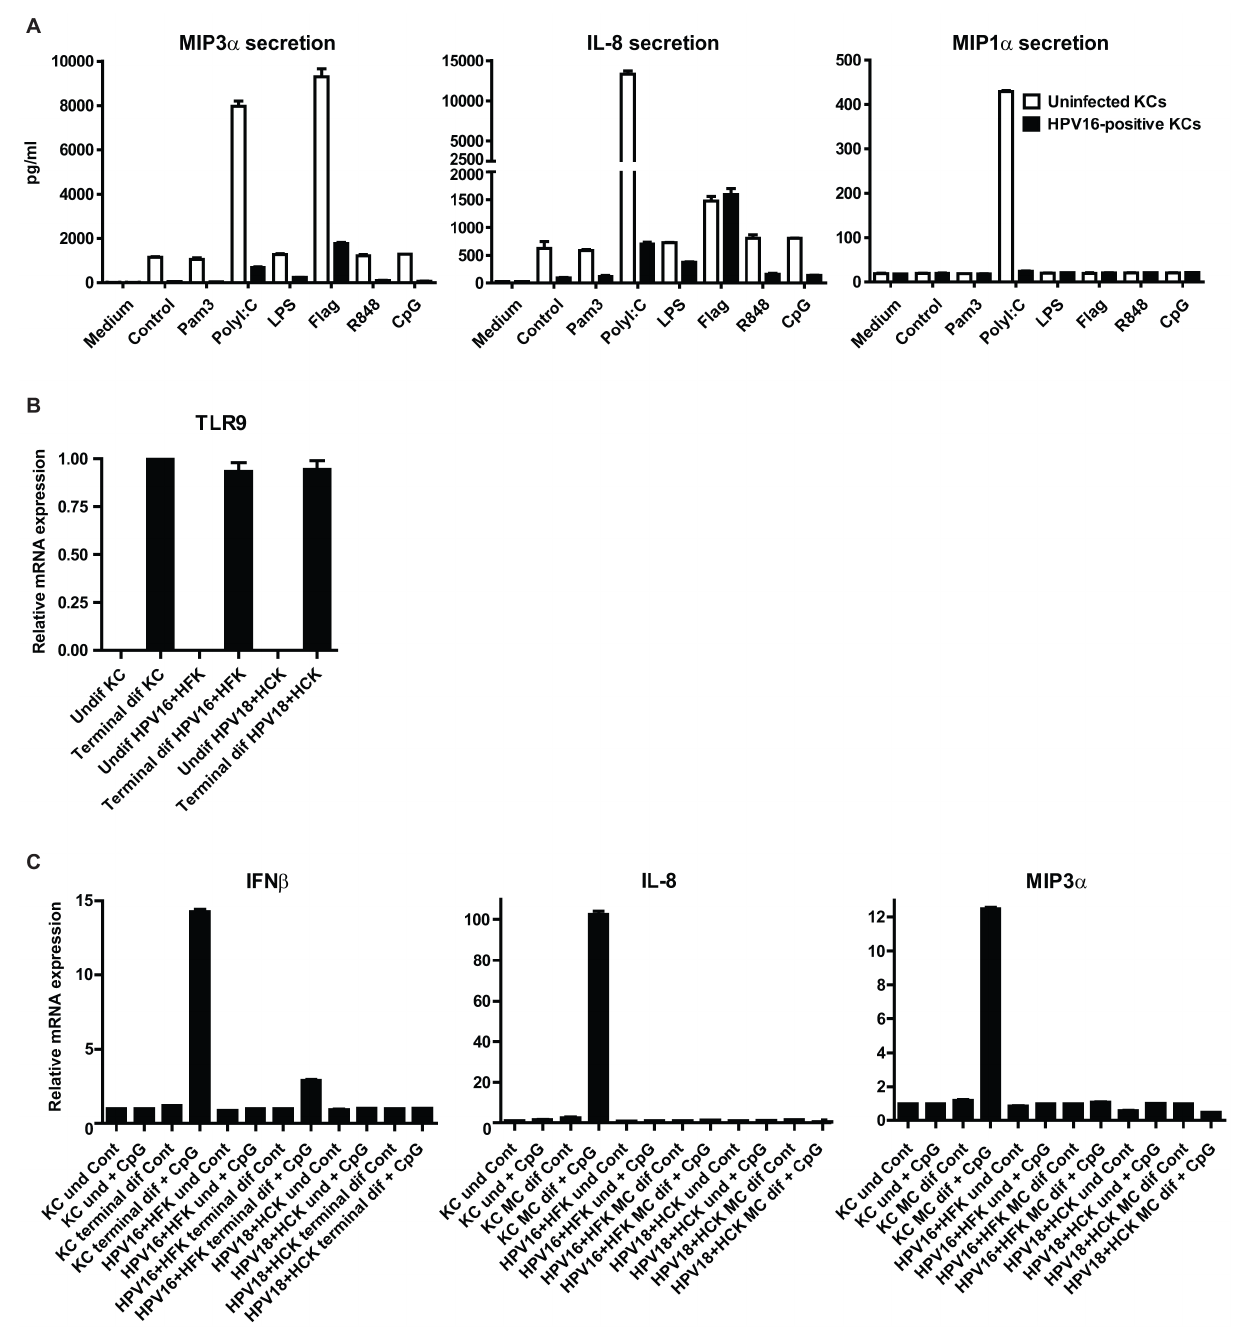
Figure 1. The presence of high risk human papillomavirus interferes with pattern recognition receptor (PRR) signaling of keratinocytes. ( A ) Cytokine production of non-differentiated uninfected or HPV16 + keratinocytes after stimulation with different indicated PRR stimuli as measured by ELISA. ( B ) TLR9 expression as measured by qRT-PCR on total RNA samples from undifferentiated (und) and terminally differentiated (terminal dif) uninfected KCs, and HPV16 and HPV18 positive KC cultures. ( C ) IFN b , IL-8 and MIP3 a expression levels in unstimulated or CpG ODN-stimulated uninfected KCs, and two different HPV (16 or 18) positive KC cultures as examined by qRT-PCR. KCs were either left undifferentiated (und) or terminally differentiated (terminal dif) after which they were stimulated with CpG (10 m g/ml) for 7 hours. ( B – C ) Gene expression was normalized using GAPDH mRNA expression levels.